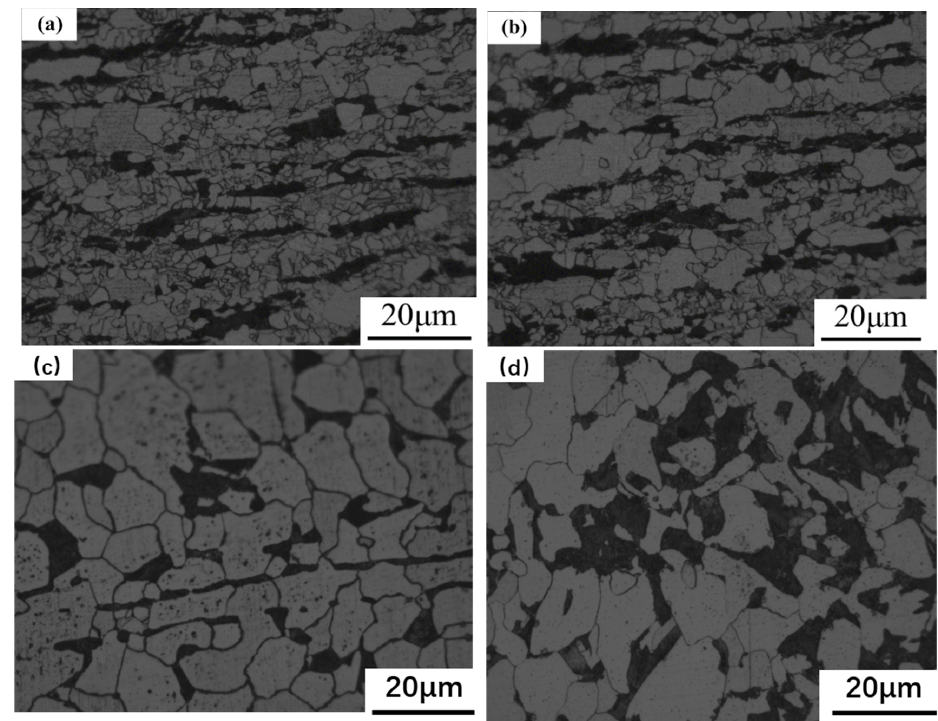
Figure 9. Microstructures of rolled specimens at different sulfur contents: ( a ) 20; ( b ) 70; ( c ) 150; and ( d ) 380 ppm. Table 2. Relationship between grain size and sulfur content.